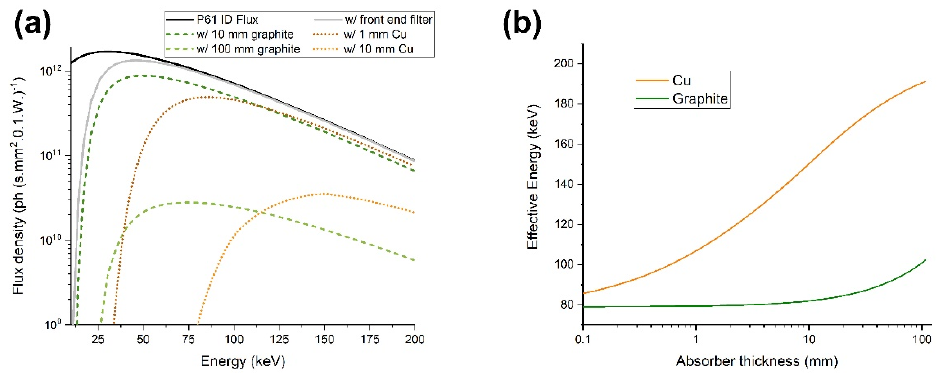
Figure 2. ( a ) Simulated energy spectrum at sample position, at Beamline P61A. Values considering a frontend filter and different thicknesses of absorber materials are also shown. ( b ) Effective energy (weighted average of attenuated spectrum) as a function of absorber thickness, calculated for Cu and